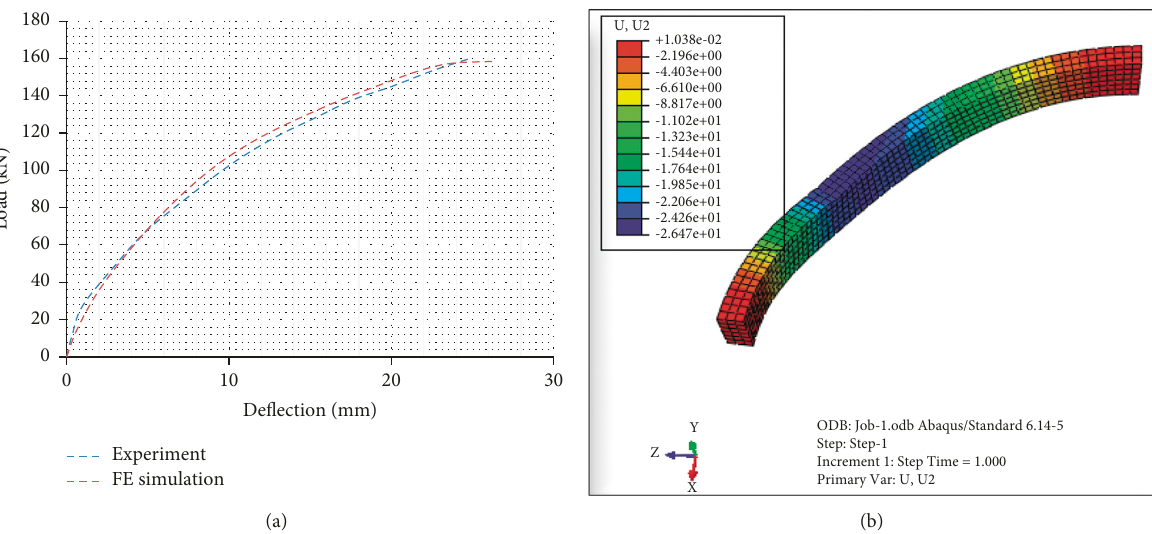
Figure 5: Comparison of FE and experimental result. (a) Load-deflection curve from experiment and FE analysis and (b) deformation response from FE analysis.